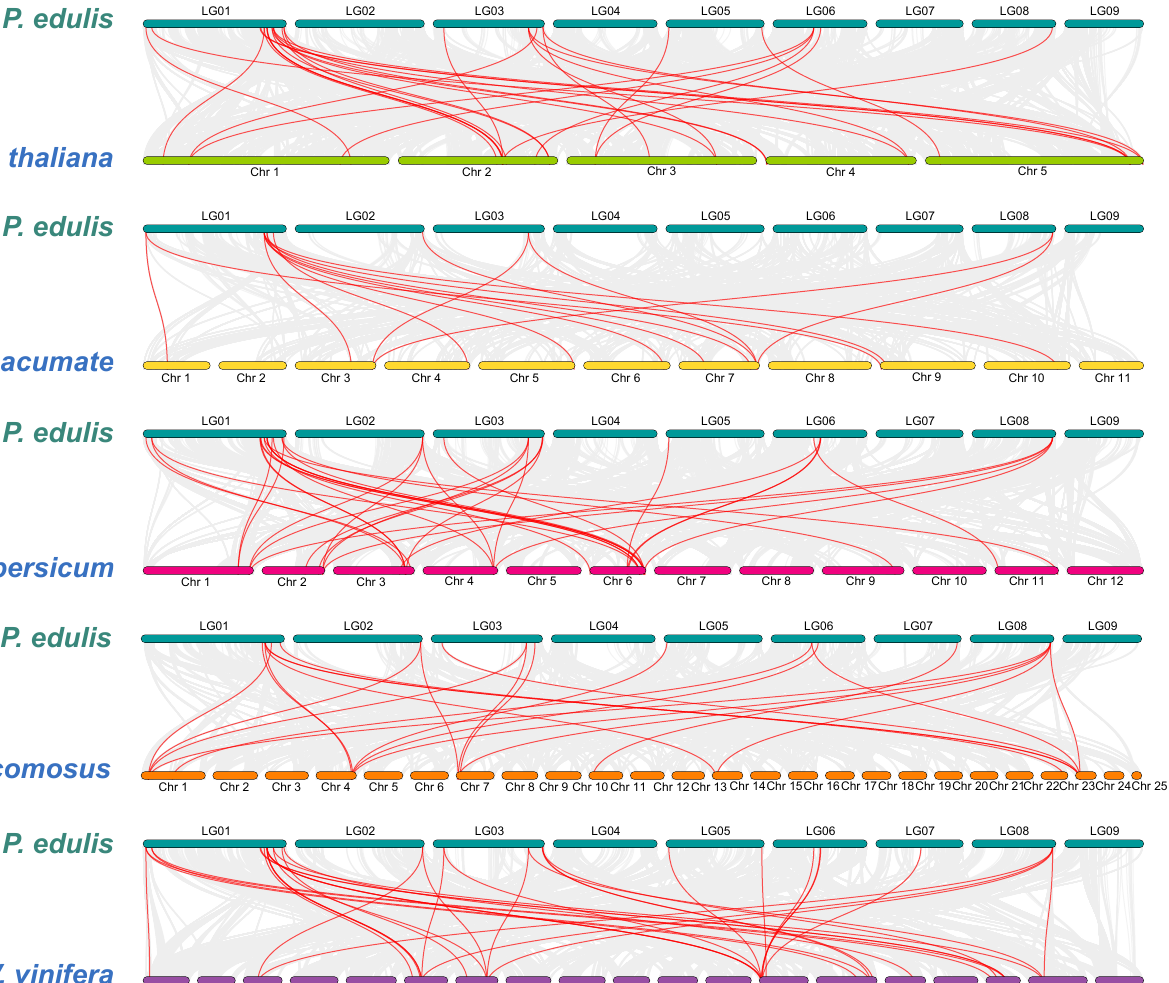
Figure 6. LBD genes synteny analysis of passion fruit and five representative plants. Grey lines in the background indicate collinear blocks in passion fruit and other plant genomes, while red lines highlight syntenic LBD gene pairs. Species names are prefixed with ‘ A. thaliana ’, ‘ M. acumi- nate ’, ‘ S.lycopersicum ’, ‘ A.comosus ’ and ‘ V.vinifera ’, denote Arabidopsis thaliana , Musa acumate , Solanum lycopersicum , Ananas comosus and Vitis vinifera ,